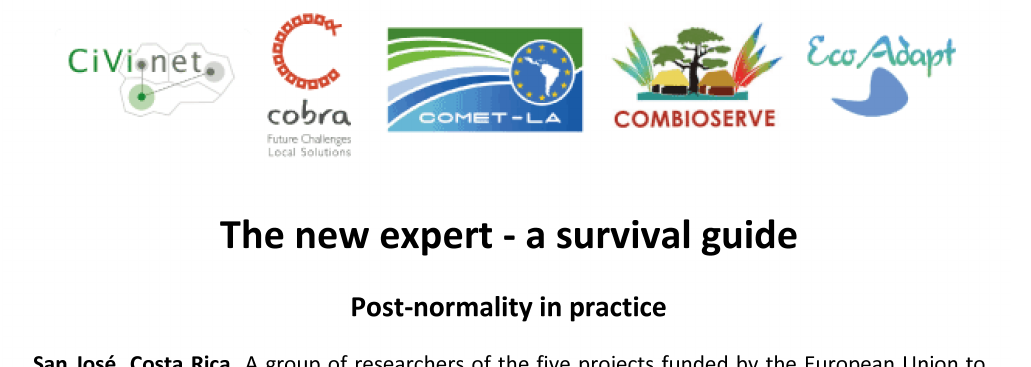
Fig. 1 . Crucial steps to improve the science–society